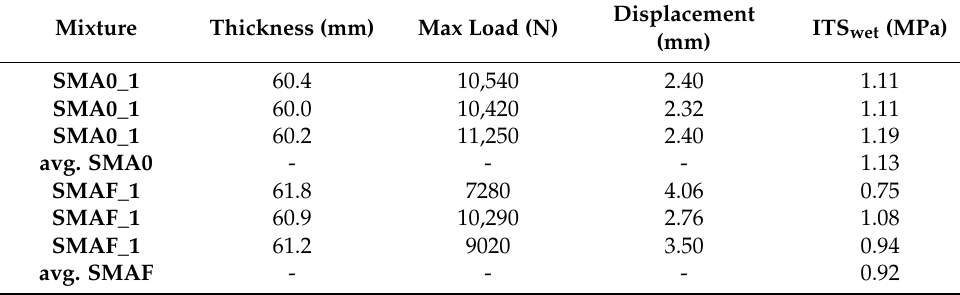
Table 8. Indirect tensile strength results after saturation in water at 40 ◦ C for 72 h.